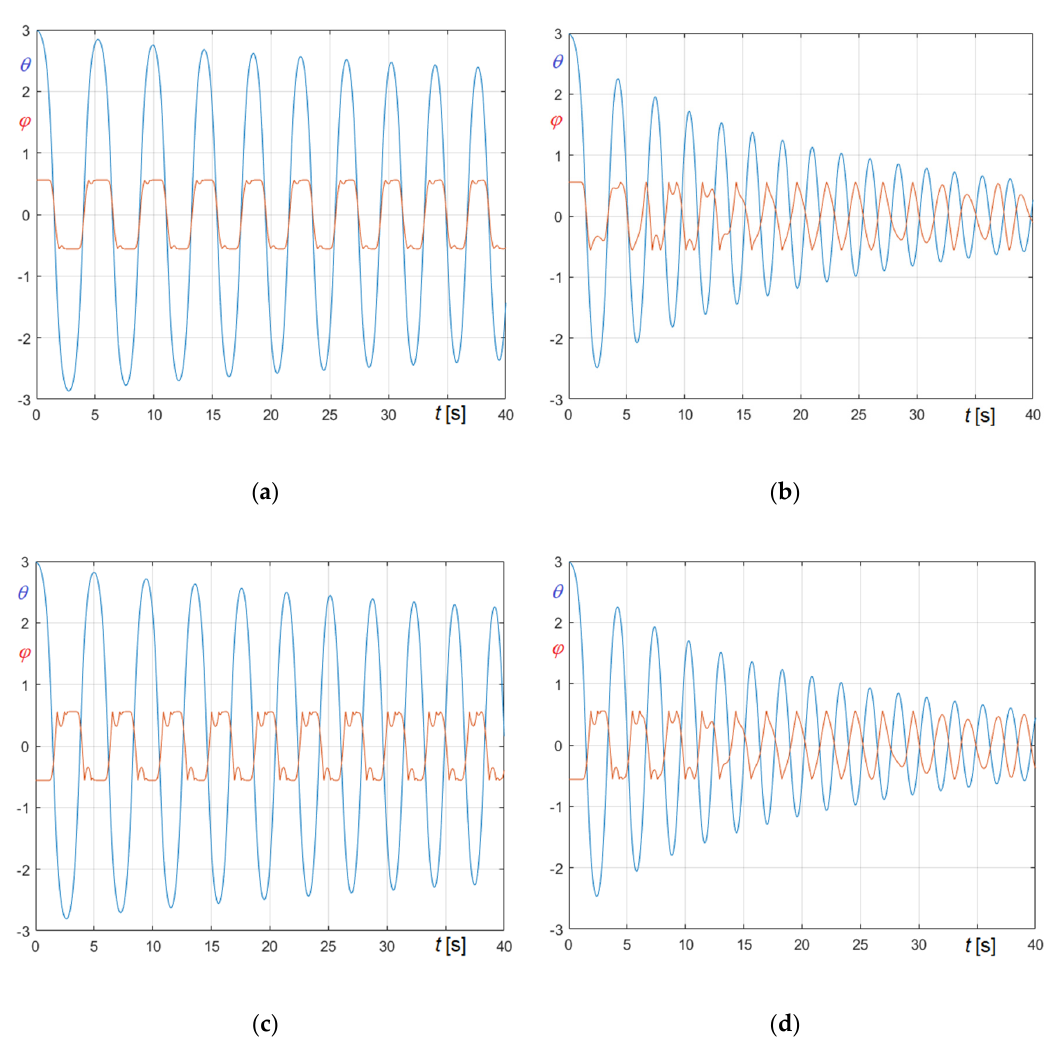
Figure 18. Comparison of friction damped and “5 ◦ equivalent” viscous damped large amplitude free oscillations of St. Mary’s tenor bell: ( a ) θ = θ ( t ) and ϕ = ϕ ( t ) curves − case I.a (friction damping); ( b ) θ = θ ( t ) and ϕ = ϕ ( t ) curves − case I.a (viscous damping); ( c ) θ = θ ( t ) and ϕ = ϕ ( t ) curves − case I.b (friction damping); ( d ) θ = θ ( t ) and ϕ = ϕ ( t ) curves − case I.b (viscous damping).